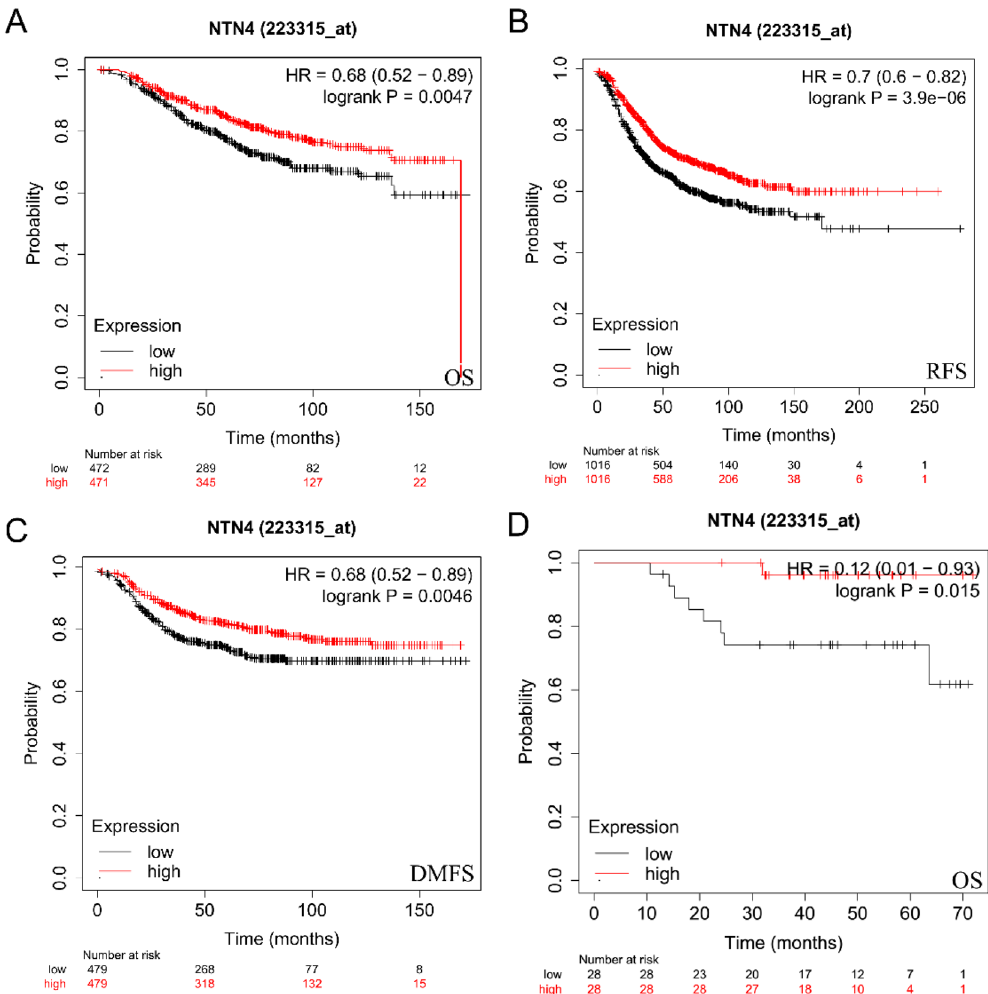
Figure 4. Kaplan–Meier survival curves compare high vs. low expression of NTN4 in breast cancer. High expression of NTN4 was associated with good survival. ( A ) OS: HR (95% CI) 0.68 (0.52–0.89), P = 0.0047. ( B ) RFS: HR (95% CI) 0.7 (0.67–0.82), P = 3.9e−06. ( C ) DMFS: HR (95% CI) 0.68 (0.52–0.89), P = 0.0046. ( D ) Overall survival in TP53 mutant population stratified by NTN4 expression levels, OS: HR (95% CI): 0.12 (0.01–0.93), P =